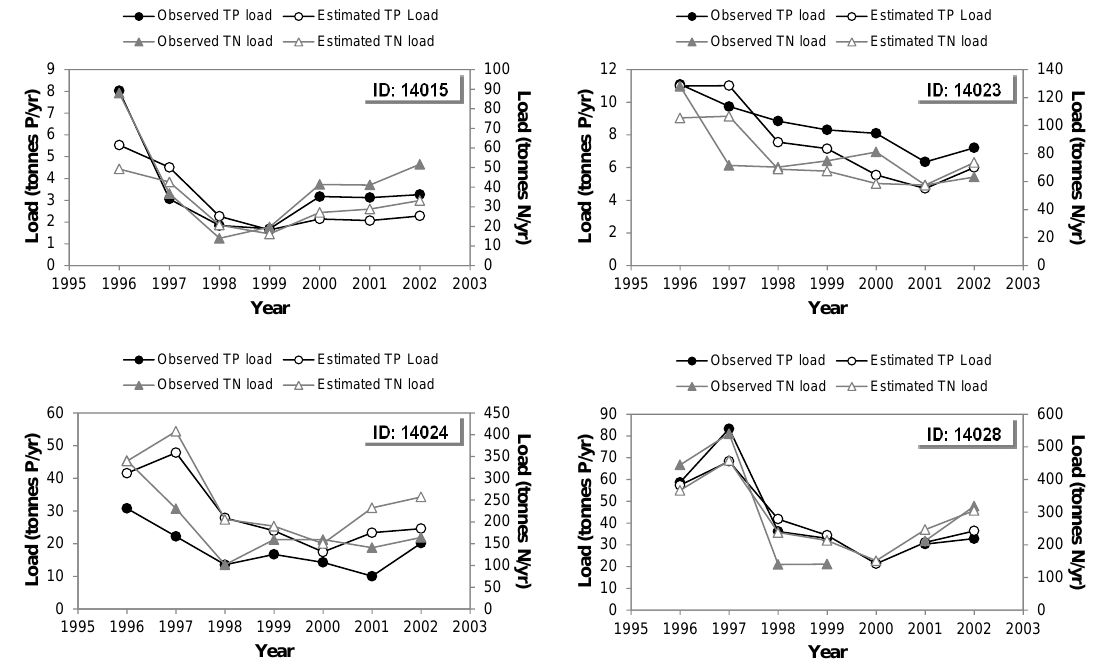
Fig. 5. Temporal evolution of observed and modelled loads of phosphorus and nitrogen for the four stations closest to the river mouth along the river, i.e. those corresponding to subcatchments 14015, 14023, 14024 and 14028 (Fig.